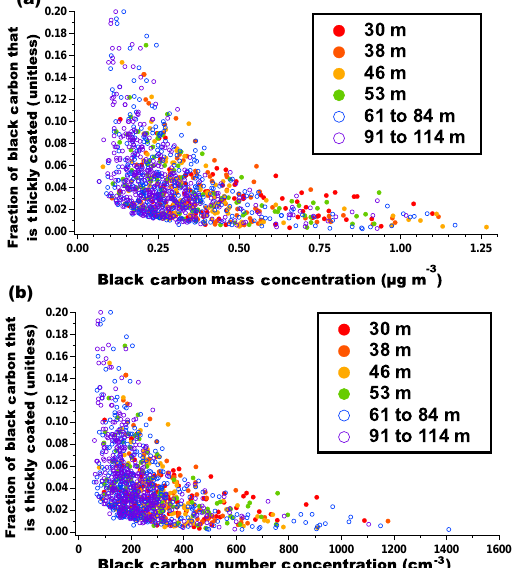
Figure 2. Fraction of black carbon that is thickly coated ( f ) vs. (a) black carbon mass concentration (µgm − 3 ) and (b) black carbon number concentration (cm − 3 ). Colors depict distances from Inter- state 405 corresponding to the measurement location. Values on this figure have been filtered to remove 10s periods with f = 0.